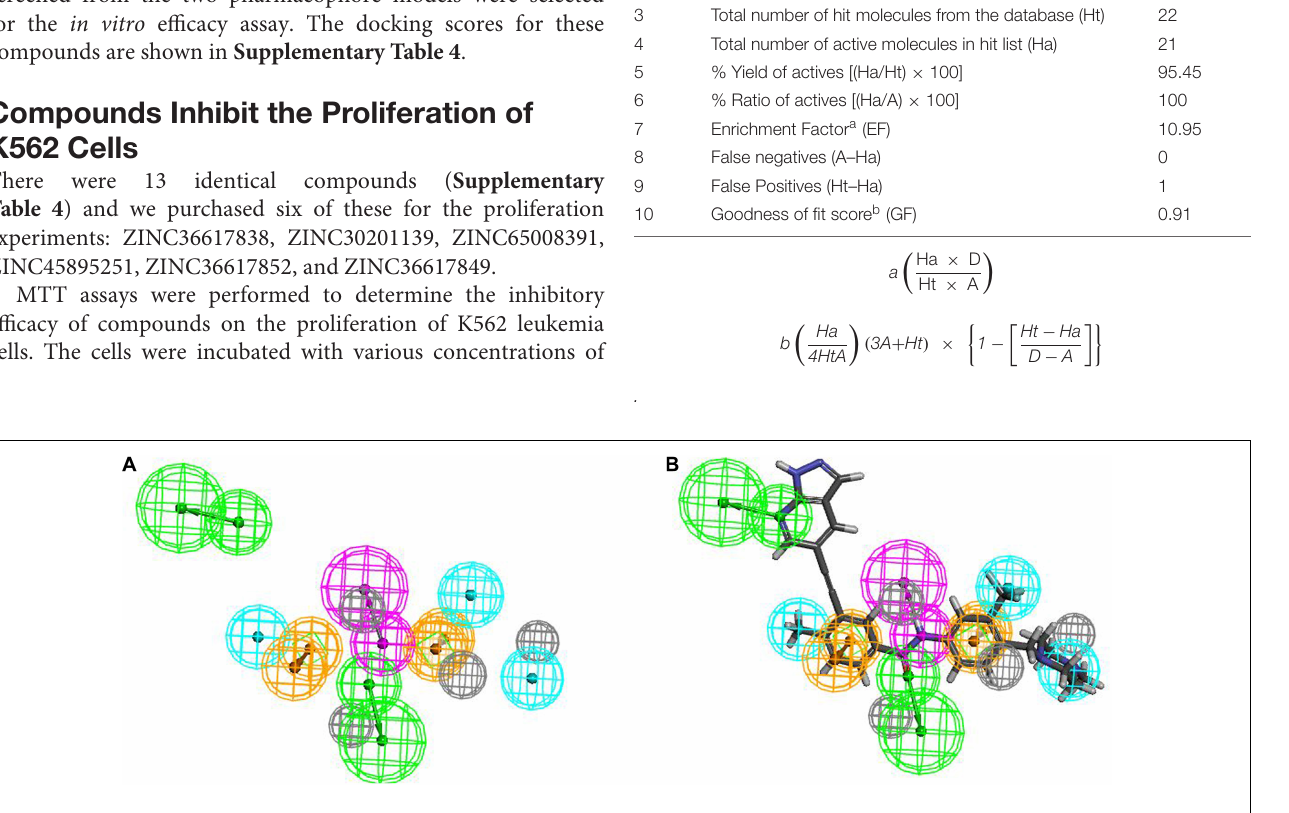
FIGURE 5 | (A) The Hiphop1 pharmacophore model. (B) Hiphop1 mapped with the most active compound.